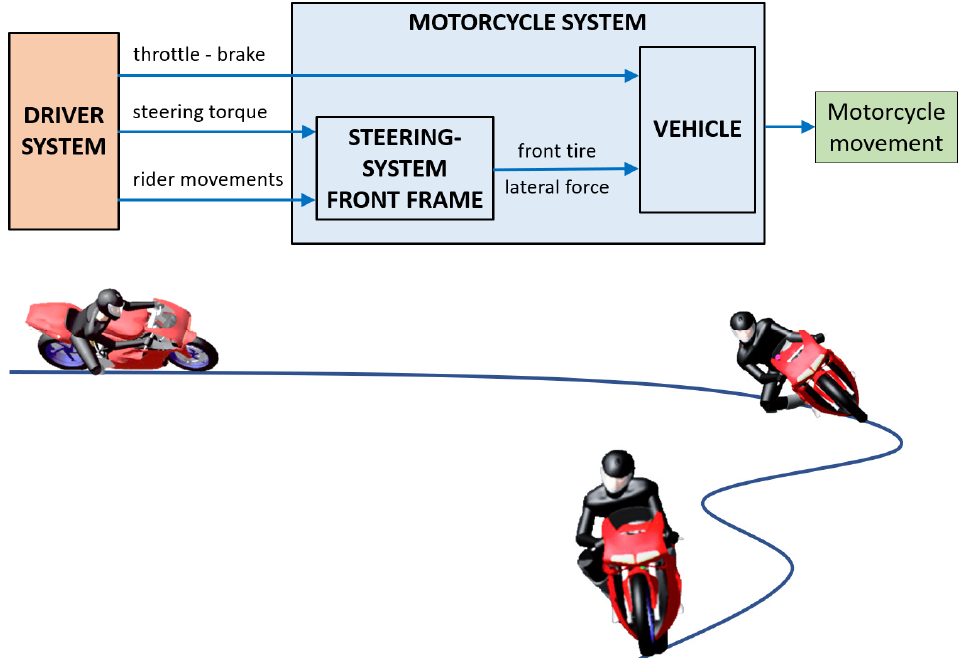
Figure 4. Scheme of the adopted PTW driver control system.